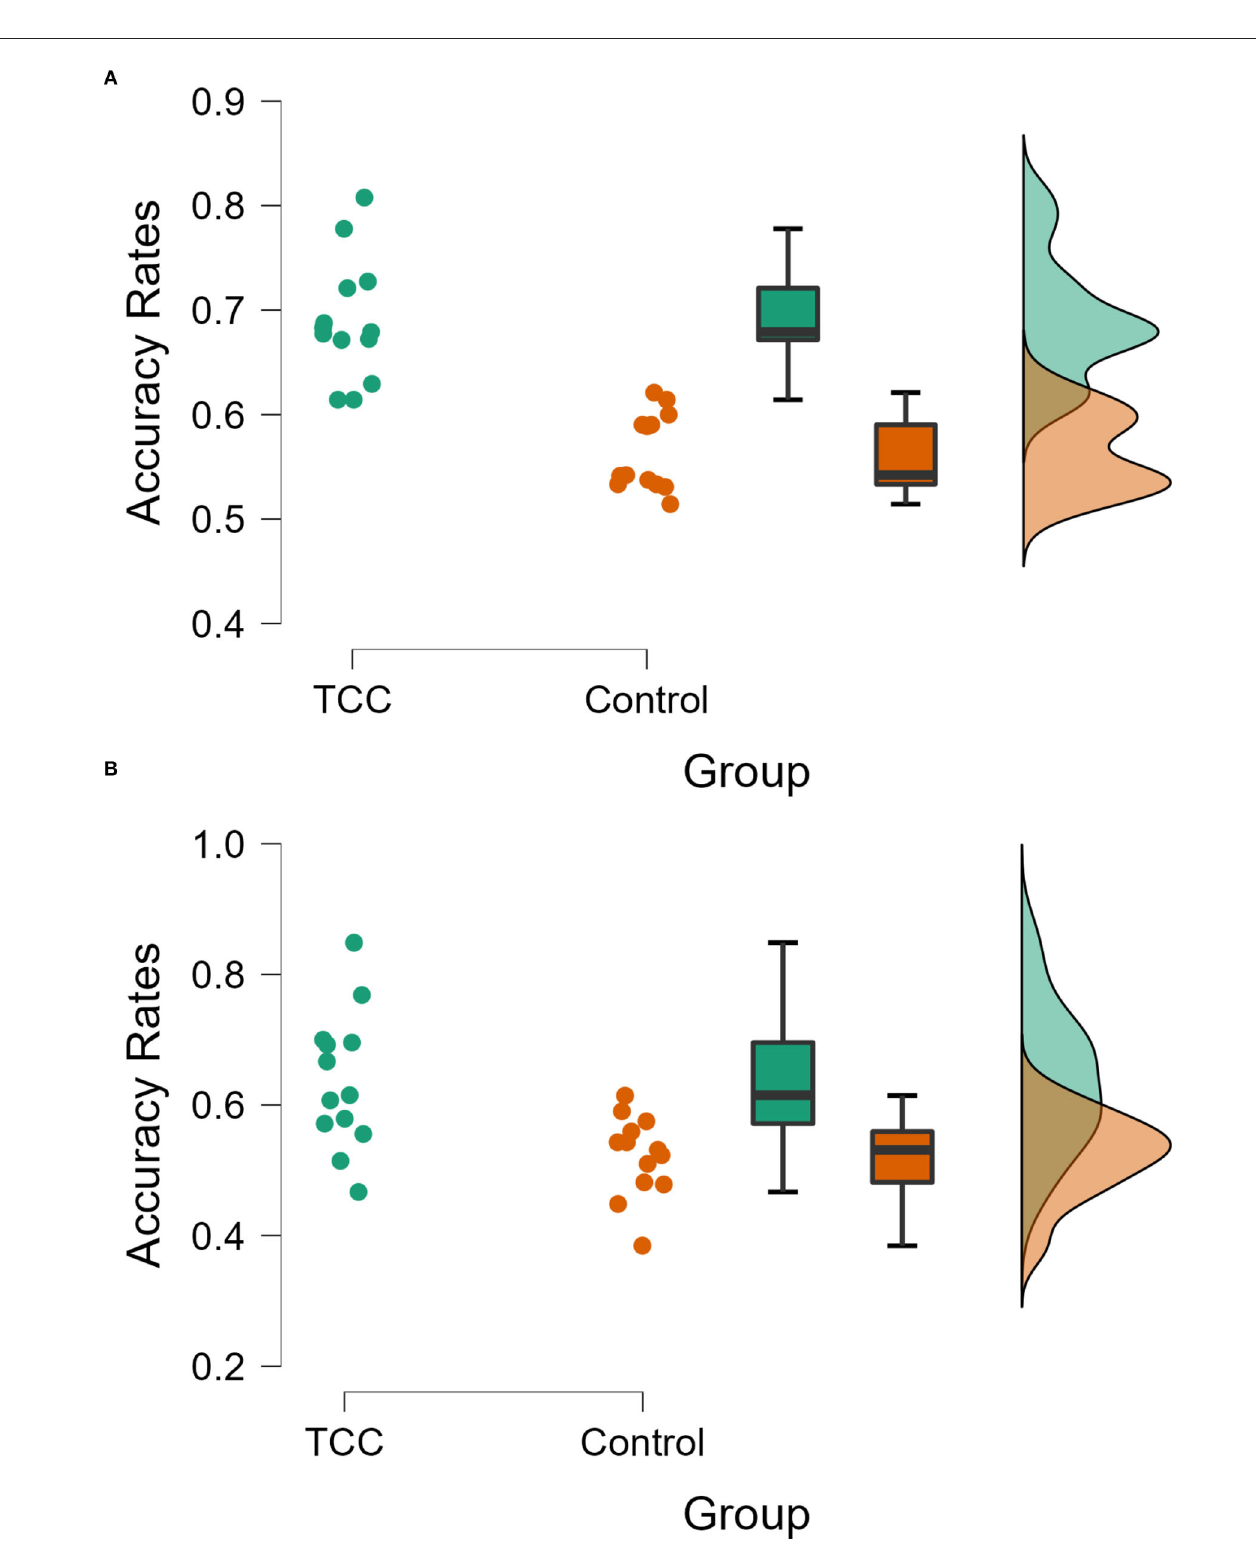
FIGURE 5 | Comparison of ARs between the two groups (TCC vs. controls) during the N-back task ( A : 1-back; B : 2-back).